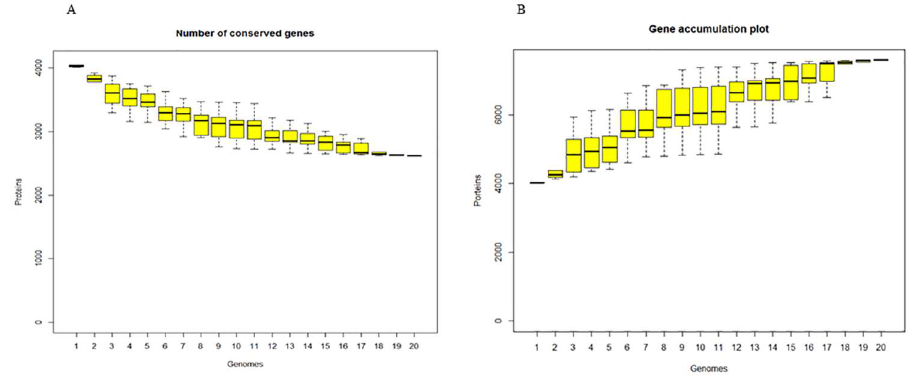
Fig 3. Core-genome and pan-genome of M . tuberculosis in lineages 1–4, based on analysis of 20 completed genomes. (A) Accumulation curve for conservedgenes in 20 re-annotated genomes.(B) Accumulation curve for total genenumbers in 20 re-annotated